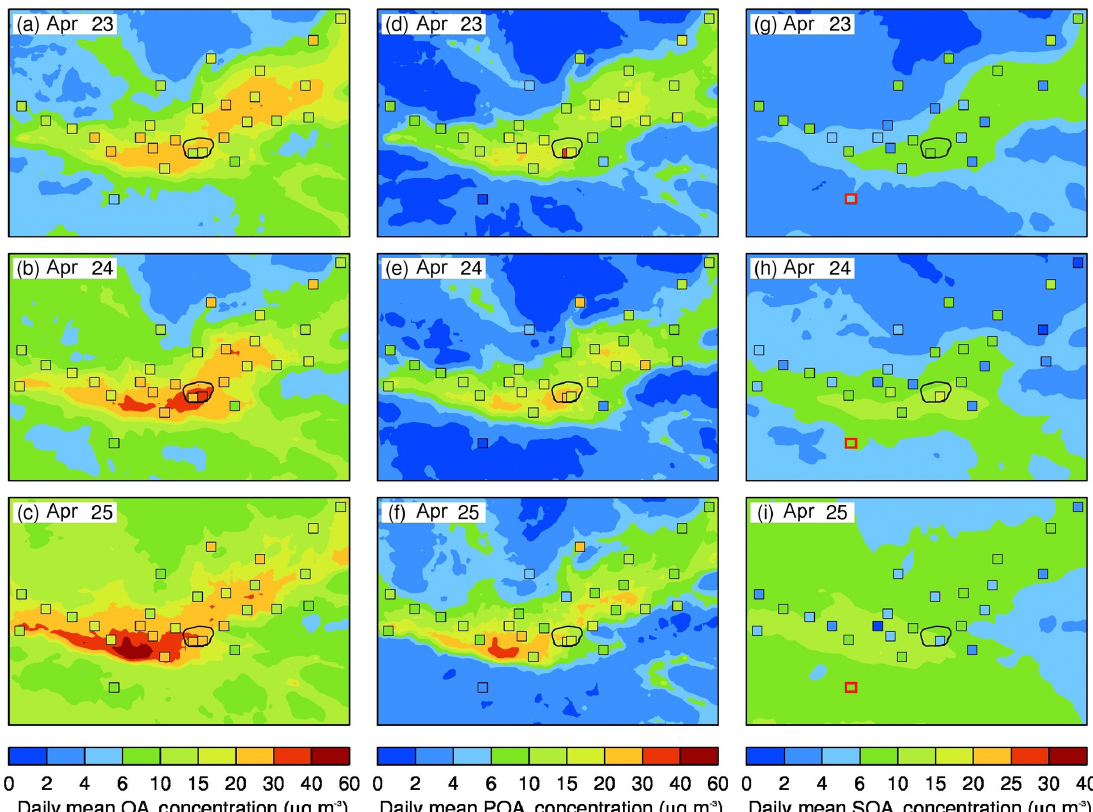
Figure 12. Spatial distributions of the NT-SOA module calculated (contours) and filter-observed (squares) daily OA (left column), POA (middle column), and SOA (right column) mass concentrations from 23 to 25 April 2013. Red squares in panels (g–i) show the location of the background site.